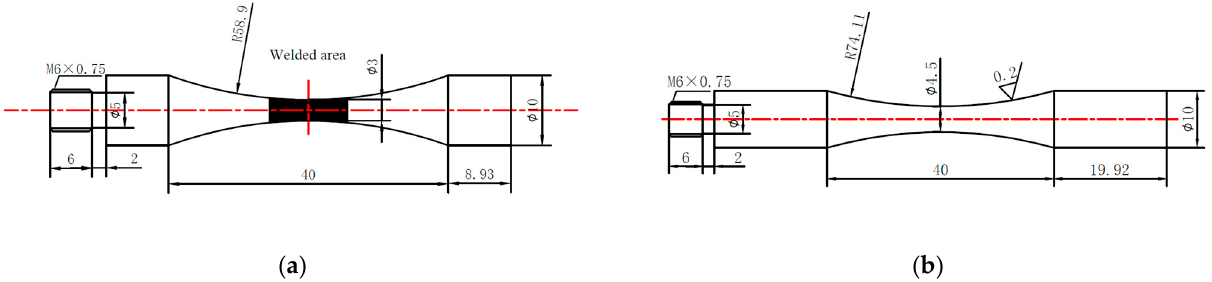
Figure 3. Shape and dimensions of the specimens (in mm) . ( a ) Welded specimen; ( b ) large